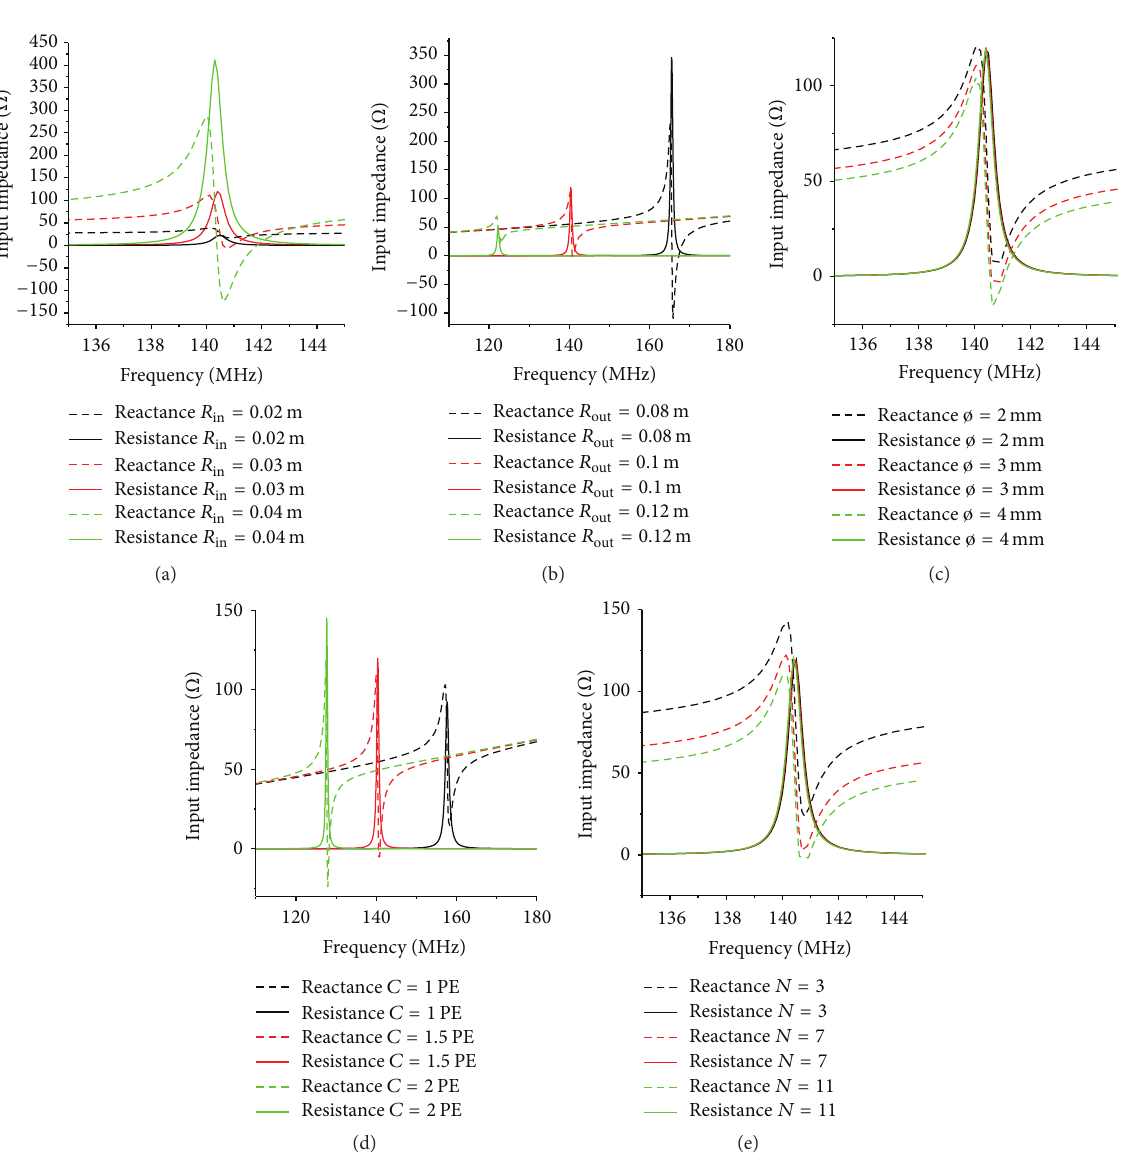
Figure 2: The complex input impedance response of proposed antenna against frequency with varied parameters. All the parameters, with exception of the variable to each corresponding subgraph, are fixed in Table 1. (a) ø = 3 mm, 𝑅 out = 100 mm, 𝐶 = 1.5 pF, and 𝑁 = 11 . (b) ø = 3 mm, 𝑅 in = 30 mm, 𝐶 = 1.5 pF, and 𝑁 = 11 . (c) 𝑅 in = 30 mm, 𝑅 out = 100 mm, 𝐶 = 1.5 pF, and 𝑁 = 11 . (d) ø = 3 mm, 𝑅 in = 30 mm, = 100 mm, and 𝑁 = 11 . (e) ø = 3 mm, 𝑅 = 30 mm, 𝑅 = 100 mm, and 𝐶 = 1.5 𝑅 out in out